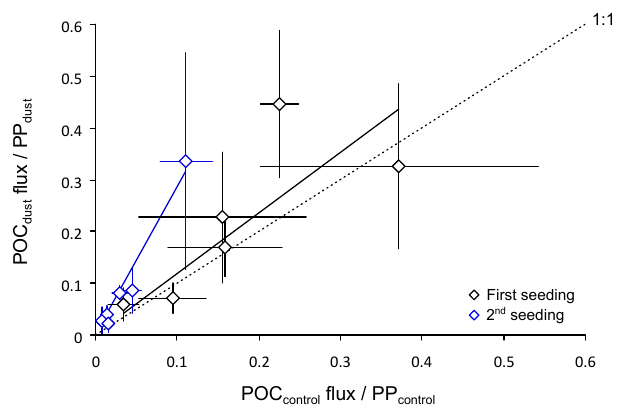
Fig. 8. POC dust versus POC control fluxes, both normalized with re- spect to integrated primary production values (PP). The best lin- ear regressions and the 1 : 1 lines are shown. First seeding: N = 6, slope=1.17 ± 0.19, R 2 = 0 . 56, p < 0 . 0001 (Fisher test). Sec- ond seeding: N = 6, slope = 2.84 ± 0.19, R 2 = 0 . 96, p < 0 . 0001 (Fisher